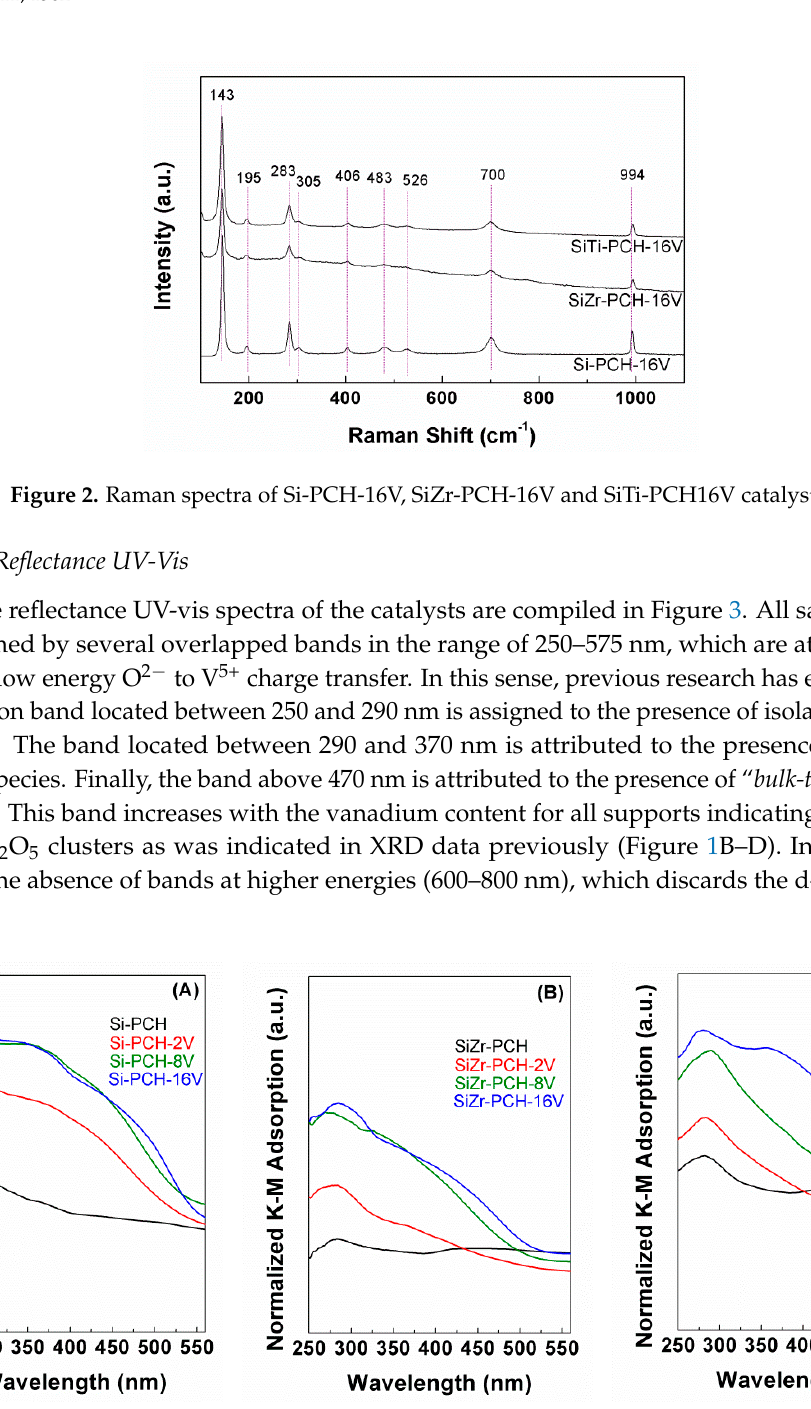
Figure 3. Diffuse reflectance UV-vis of the V-based catalysts supported on Si-PCH ( A ), of the V-based catalysts supported on SiZr-PCH ( B ) and of the V-based catalysts supported on SiTi-PCH ( C ).